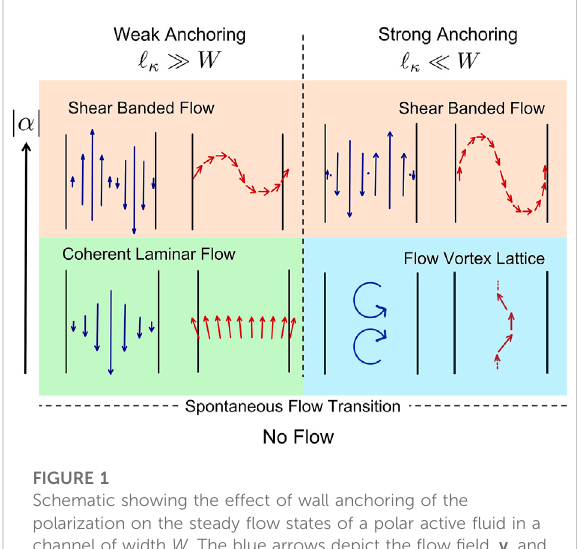
FIGURE 1 Schematic showing the effect of wall anchoring of the polarization on the steady fl ow states of a polar active fl uid in a channel of width W . The blue arrows depict the fl ow fi eld, v , and the red arrows represent the polarization, p . The extended arrow on the left indicates the direction of increasing activity | α |.